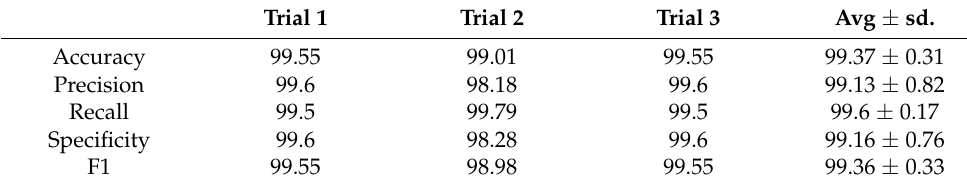
Table 5. Classification results (expressed as a percent) obtained on the CT dataset with a split of 20:80. Trial